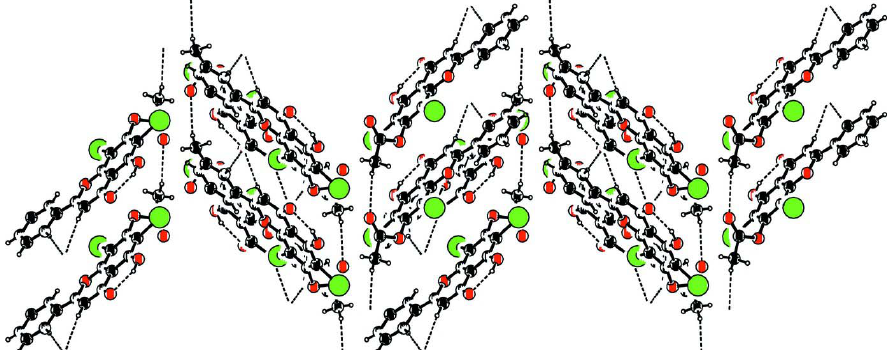
Figure 3 Cooperative H-bonded network of O–H···O interactions viewed down the a